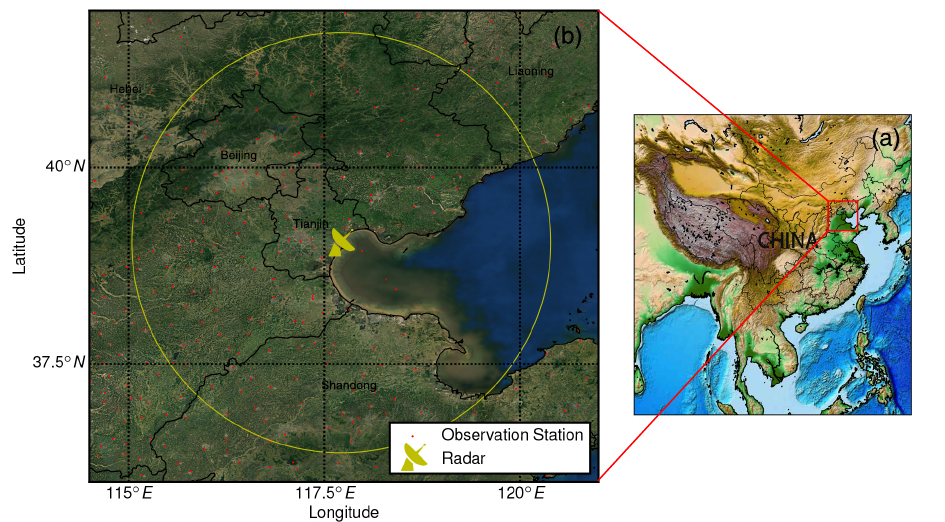
Figure 2. ( a ) General view of study area. ( b ) Zoomed view of the study area with the Tianjin radar and manual observation stations. The yellow circle shows the scanning range of the Tianjin